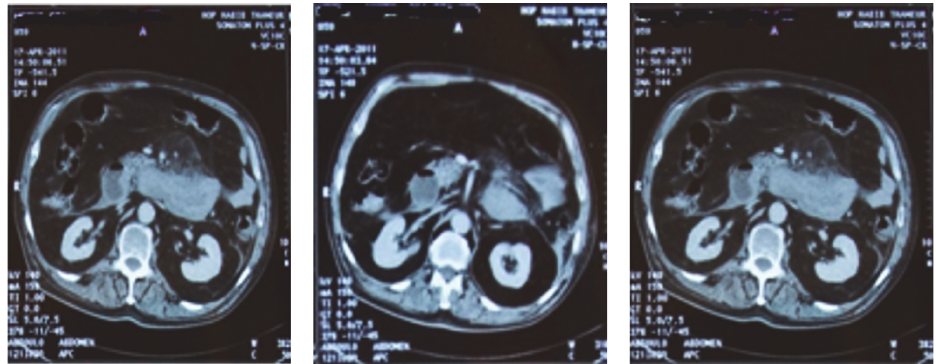
Figure 2: Extensive hematoma from the third portion of duodenum to the last jejunal